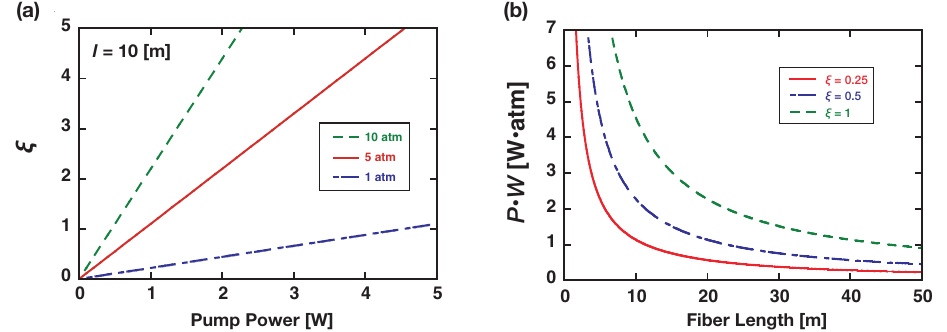
Figure 3. ( a ) Evolution of ξ as a function of pump beam power for hydrogen pressures of 1, 5, 10 atm in a 10-m HC-PCF. ( b ) Dependence on the HC-PCF length of the product of the pump power and the hydrogen pressure needed to satisfy ξ = 0.25,0.5,1.